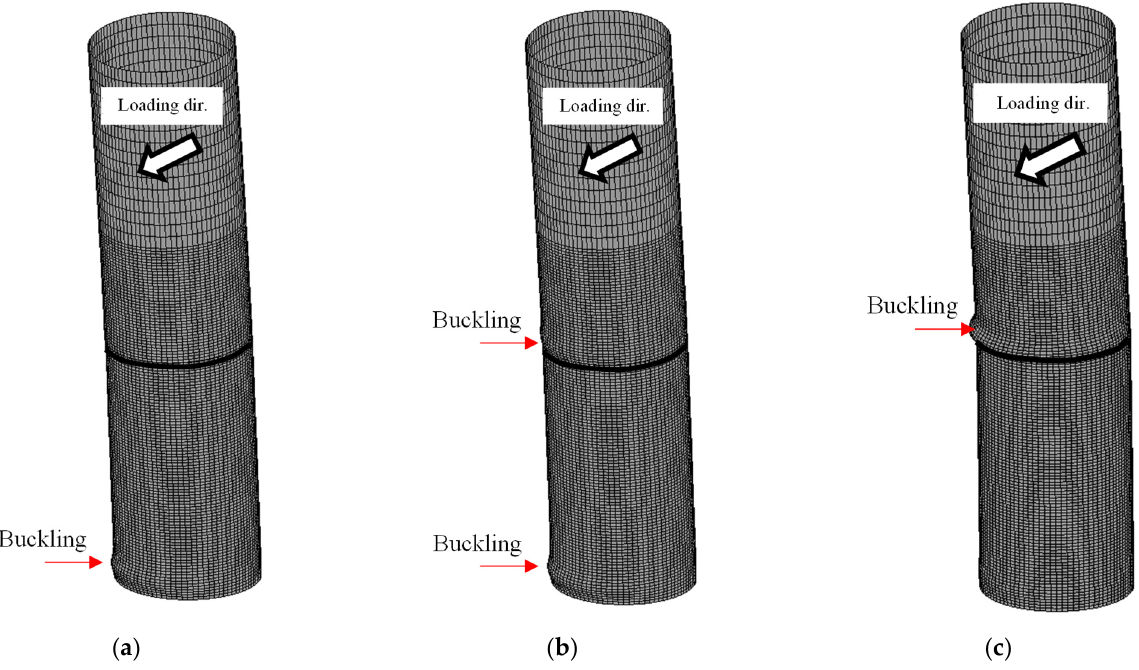
Figure 7. Typical failure modes (C-009-030, L c / L = 0.4): ( a ) n = 0.1; ( b ) n = 0.2; ( c ) n = 0.3.